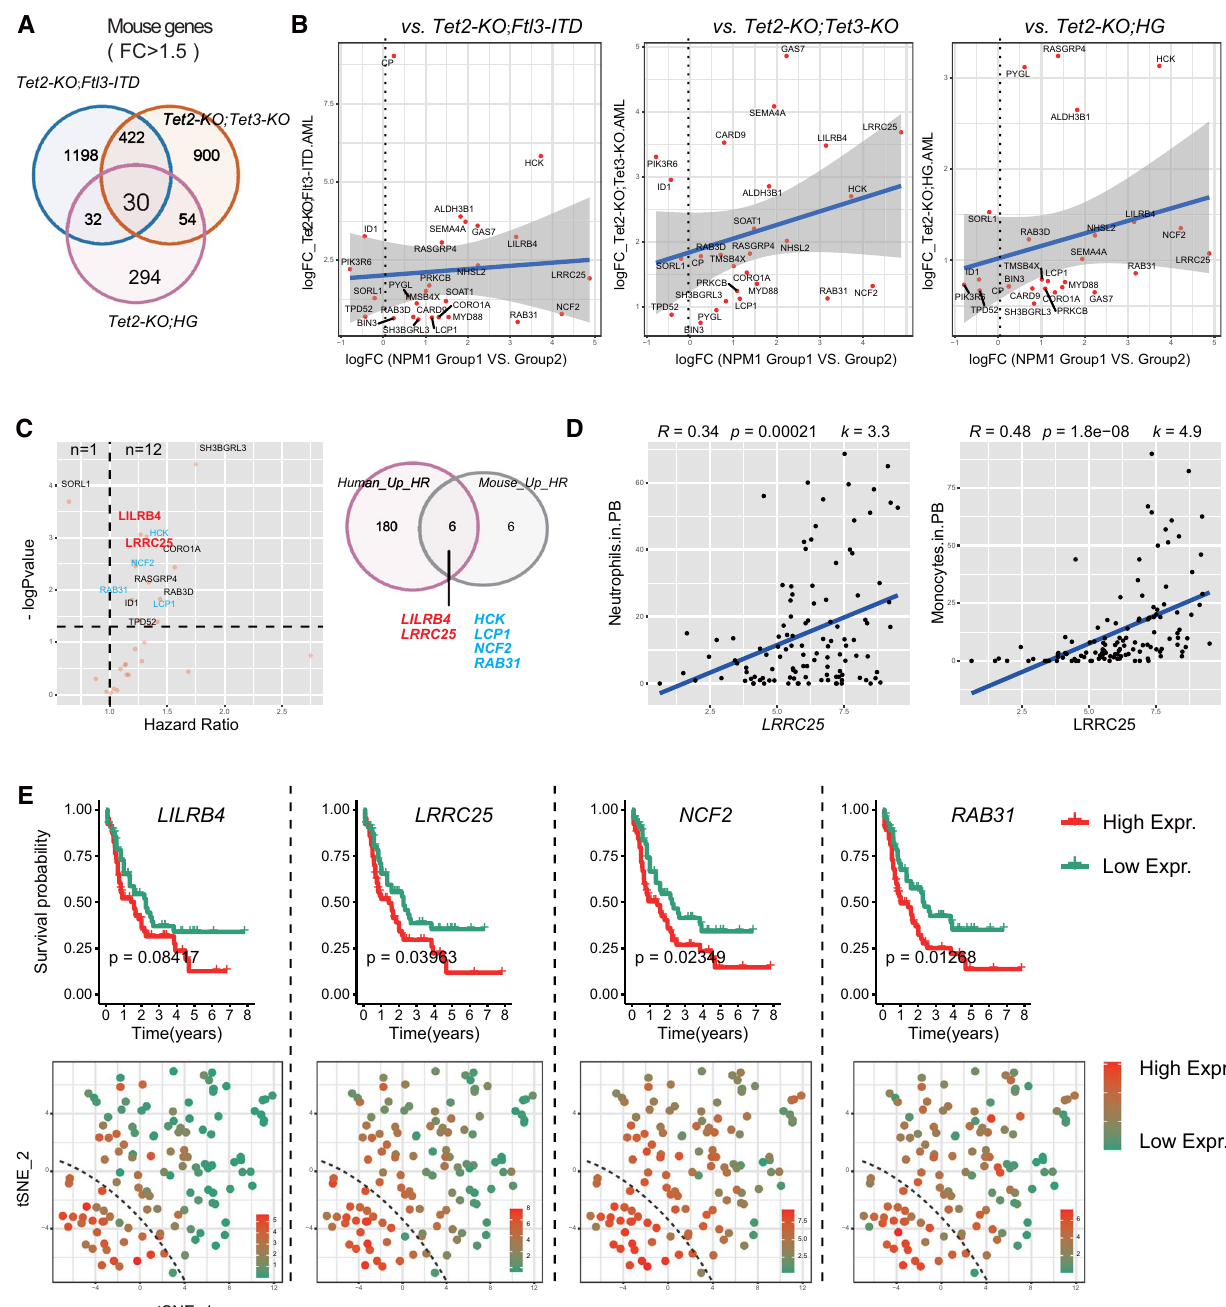
Fig. 5 Transcriptomic datasets from murine AML models further assistants the screening of essential DEGs for characterizing NPM1_Group1 patients. A Venn diagrams of DEGs in three TET2 mutation-related AML mouse datasets: Tet2 −/− ; Tet3 −/− ( Tet2 -KO; Tet3 -KO) − , Tet2 −/− ; Flt3ITD ( Tet2 -KO; Flt3ITD ) and Tet2 −/− ; Ins2 Akita/ + ( Tet2 -KO; HG). In total, 30 genes co-upregulated in the three murine AML models are prioritized (fold change > 1.5, p < 0.05). B Correlation plots of gene expression changes of transcriptomes from NPM1 _Group1 vs. Group2 comparison of NIH- TCGA datasets and from murine sources of AML datasets. Each red dot represents a homologous gene. X-axis, logFC value from NPM1 _ Group1 vs Group2 comparison in the NIH-TCGA dataset; Y-axis, logFC value from the comparisons in murine datasets respectively. The blue line is a linear regression fitting based on all genes’ logFC value. Gray area: 95% confidence interval. C Among the 30 co-upregulated